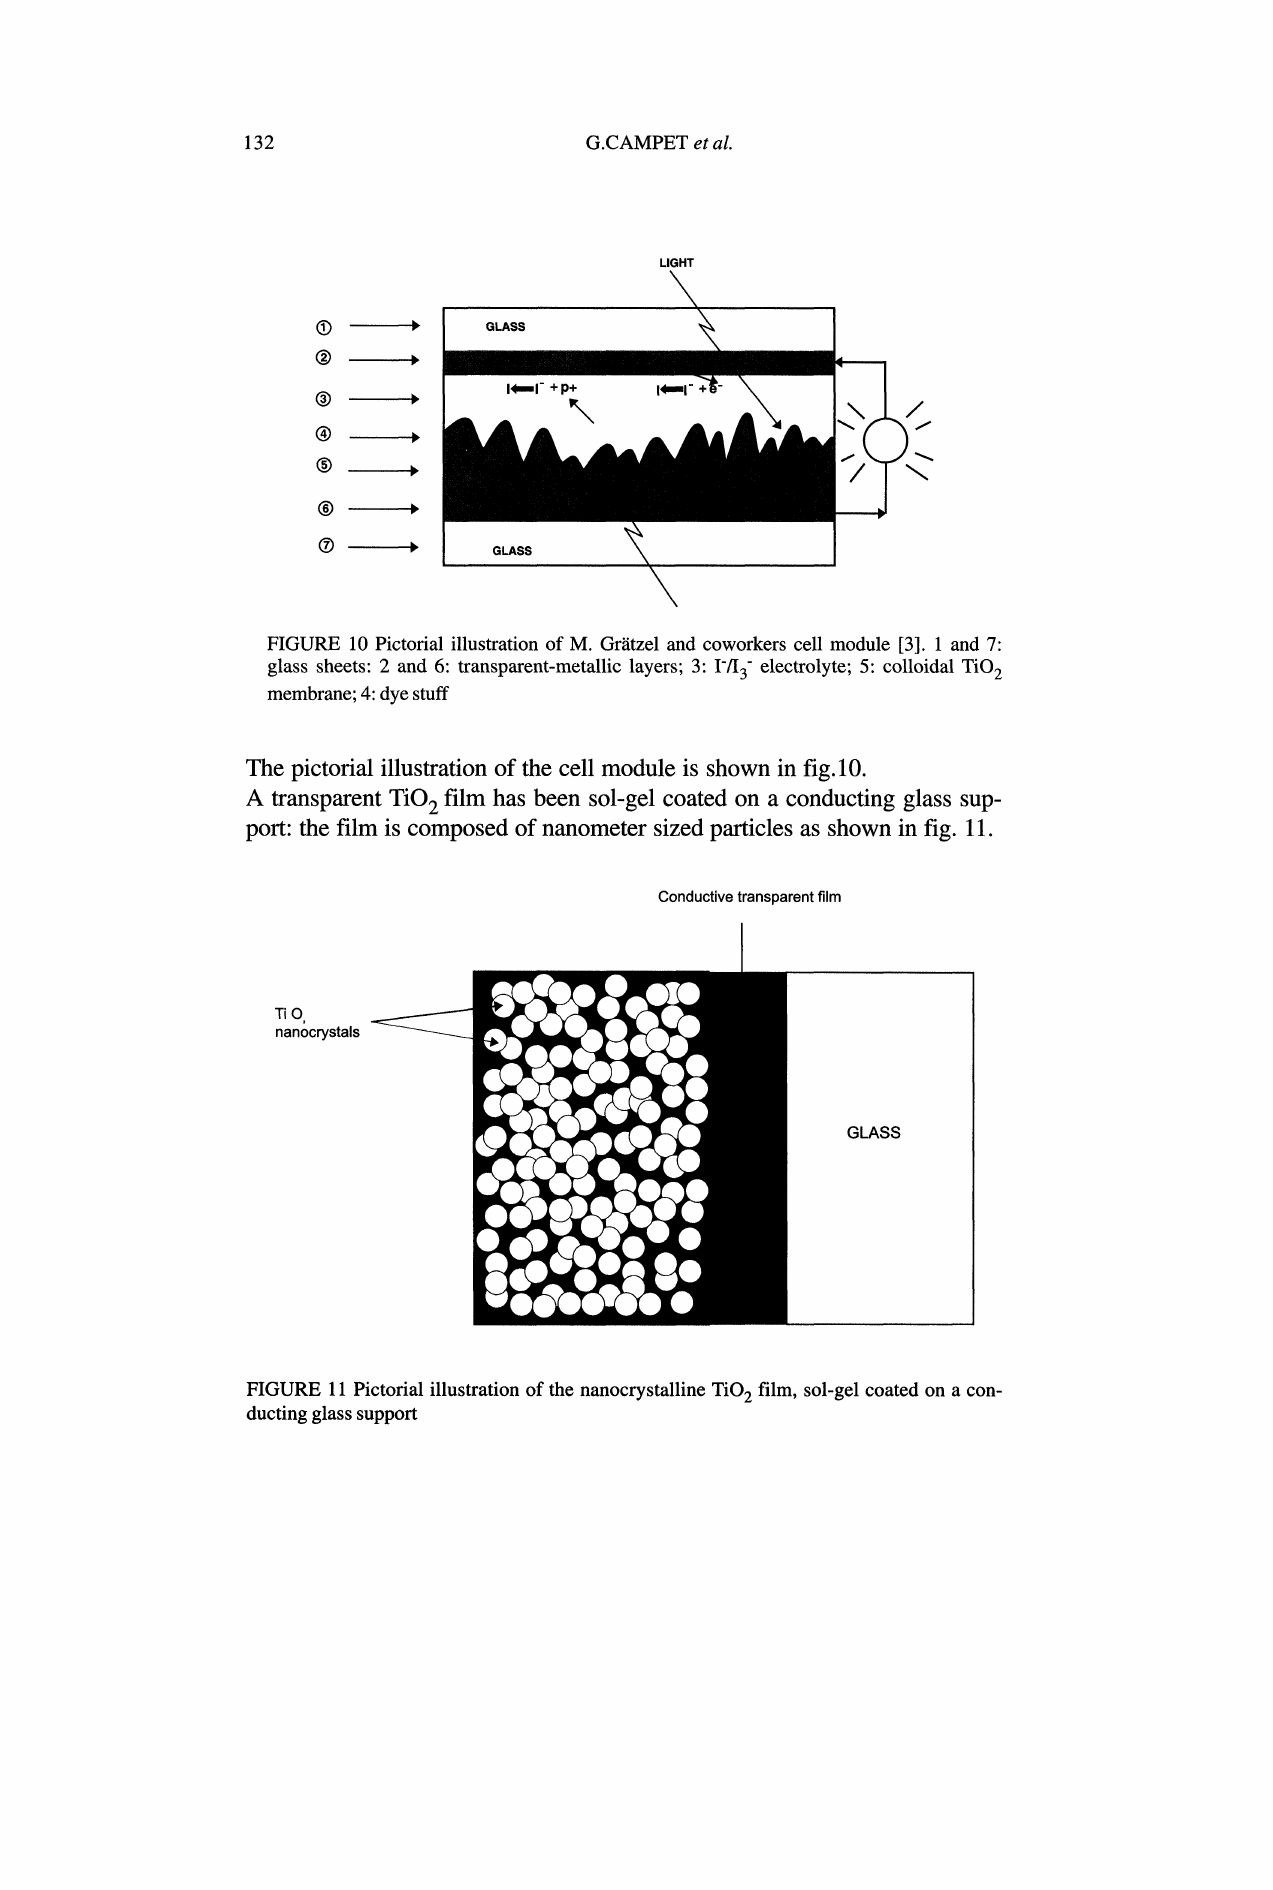
FIGURE 11 Pictorial illustration of the nanocrystalline TiO ducting glass